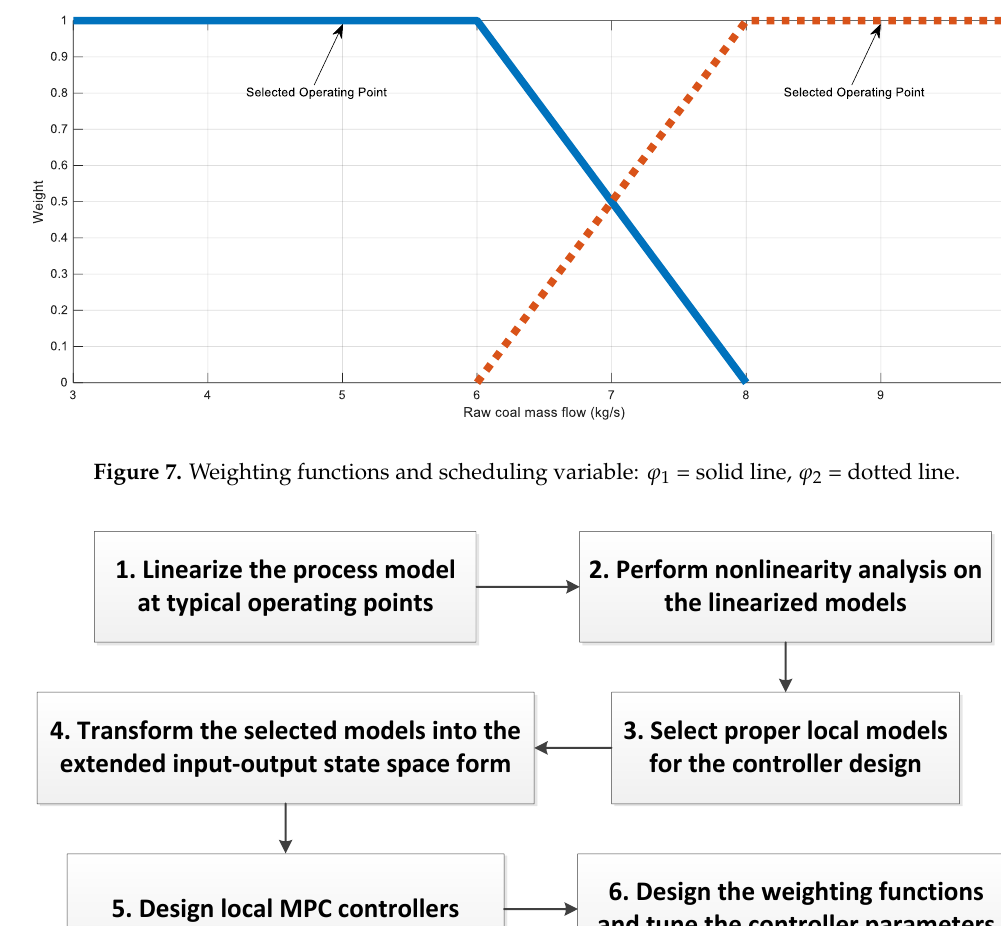
Figure 8. Design procedures of proposed MMPC.